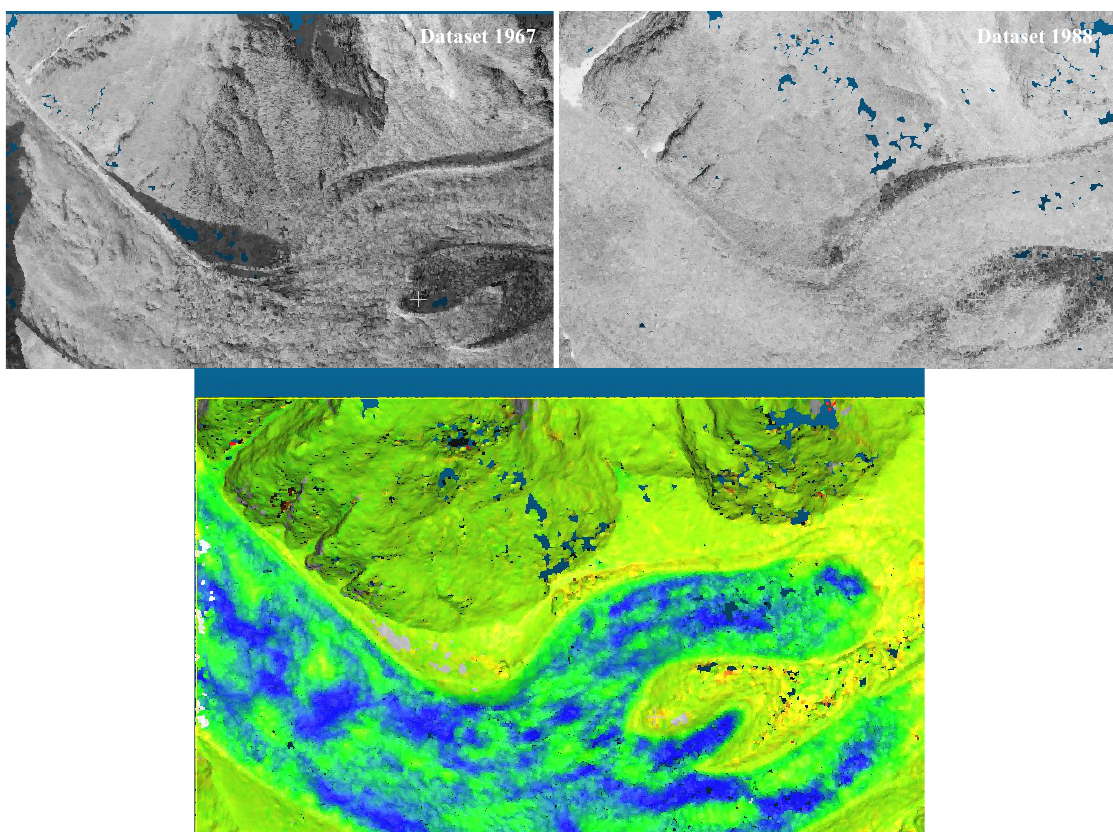
Figure 4. Result of the comparison based on M3C2 technique between Datasets 1967 and 1988 (panchromatic) over the terminus of Miage Glacier in Val Veny (distances in [m]). In the upper part the point clouds obtained from the application of MSfM are shown. After ICP refinement of coregistration, point clouds have been compared by means of M3C2 (see the map of changes in the lower